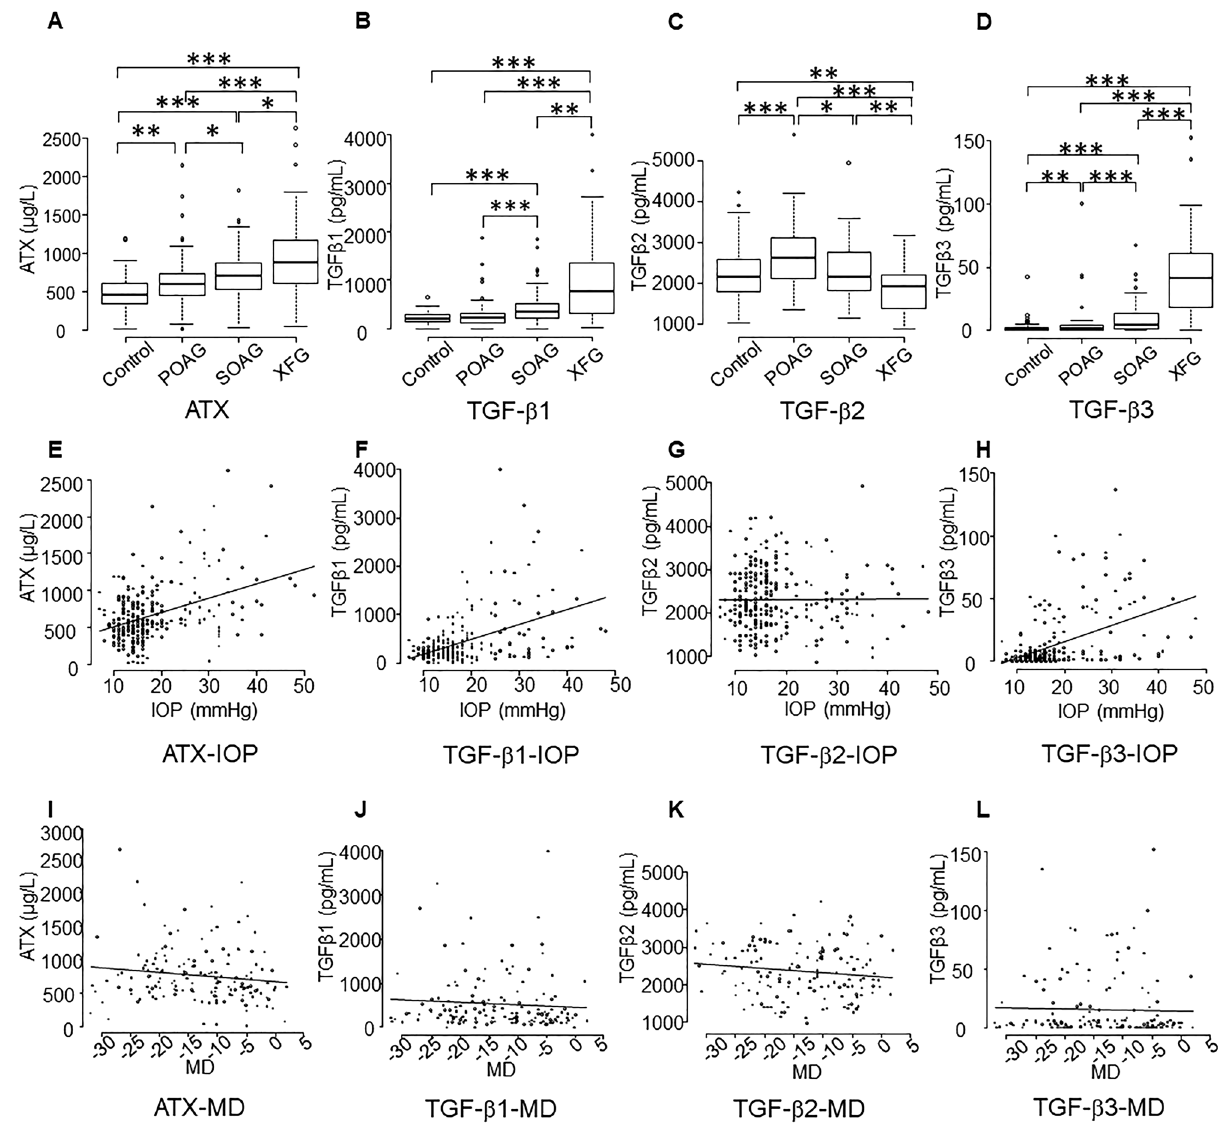
Figure 1. Relationships between aqueous autotaxin (ATX), transforming growth factor-beta 1 (TGF-β1), TGF-β2, and TGF-β3 levels and glaucoma subtypes, intraocular pressure (IOP), and the mean deviation (MD). ( A – D ) Relationships between aqueous ATX ( A ), TGF-β1 ( B ), TGF-β2 ( C ) and TGF-β3 ( D ) levels and glaucoma subtypes. ( A ) ATX levels measured via an immunoenzymetric assay were significantly higher in the exfoliation glaucoma (XFG) group compared with the other groups. Also, there was significant differences between the secondary open-angle glaucoma (SOAG) group and the normal (Control) and primary open- angle glaucoma (POAG) groups, and between the Control and POAG groups. ( B ) Aqueous TGF-β1 levels were significantly higher in the XFG group compared with the other groups. Also, TGF-β1 levels in the SOAG group were significantly higher compared with the normal and POAG groups. ( C ) Aqueous TGF-β2 levels were significantly higher in the POAG groups compared to the other groups, and TGF-β2 levels in the XFG group were significantly lower compared to the Control and SOAG groups. ( D ) Aqueous TGF-β3 levels were significantly higher in the XFG group compared to the other groups. TGF-β3 levels in the SOAG group were significantly higher compared with the Control and POAG groups, and significantly higher in the POAG group compared to the Control group. * P < 0.05, ** P < 0.01, *** P < 0.001. ( E – H ) Correlations between IOP and aqueous ATX ( E ), TGF-β1 ( F ), TGF-β2 ( G ), and TGF-β3 ( H ). ATX ( E ; Spearman’s rank correlation coefficient = 0.315, P = 0.0000000663), TGF-β1 ( F ; Spearman’s rank correlation coefficient = 0.336, P = 0.00000000964), and TGF-β3 ( H ; Spearman’s rank correlation coefficient = 0.453, P = 1.83e−15) were positively correlated with IOP, whereas TGF-β2 ( G ) was not (Spearman’s rank correlation coefficient = 0.0238, P = 0.693). ( I – L ) Relationships between the MD and aqueous ATX ( I ), TGF-β1 ( J ), TGF-β2 ( K ), and TGF-β3 ( L ). Correlations between the MD and aqueous levels of ATX, TGF-β1, TGF-β2, and TGF-β3 were analyzed. Only ATX exhibited a negative correlation with MD ( I ; Spearman’s rank correlation coefficient = − 0.17, P = 0.035); TGF-β1 ( J ; Spearman’s rank correlation coefficient = − 0.155, P = 0.0576), TGF-β2 ( K ; Spearman’s rank correlation coefficient = − 0.144, P = 0.0788), and TGF-β3 ( L ; Spearman’s rank correlation coefficient = − 0.122, P = 0.135) did not exhibit significant